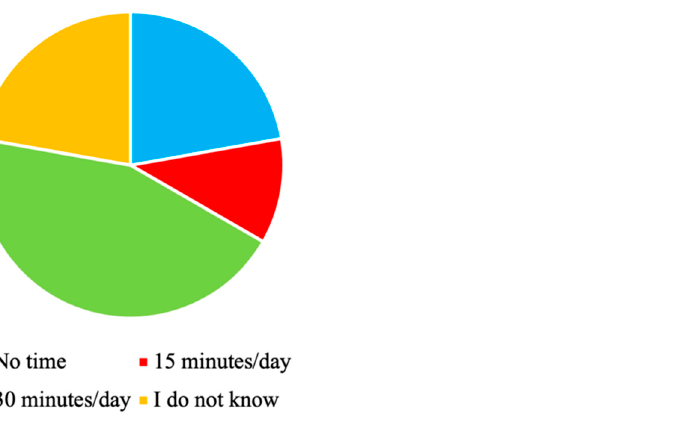
Figure 7. Maximum time that the participants are willing to dedicate to SFRA (N = 8).